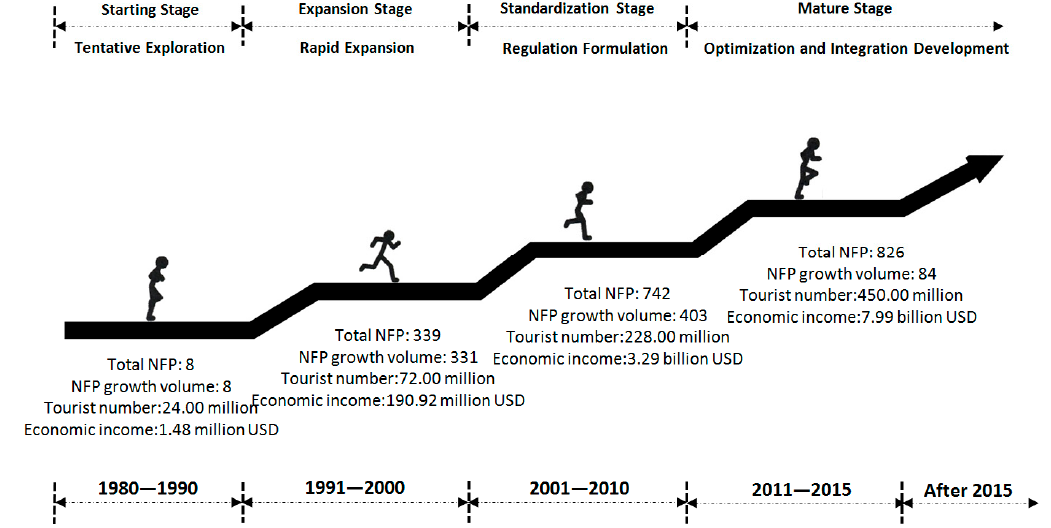
Figure 3. The development stages of the NFPs in China. (Information obtained from National Forestry and Grassland Administration (NFGA): http://www.forestry.gov.cn/, drawing designed and drawn by the first author,).